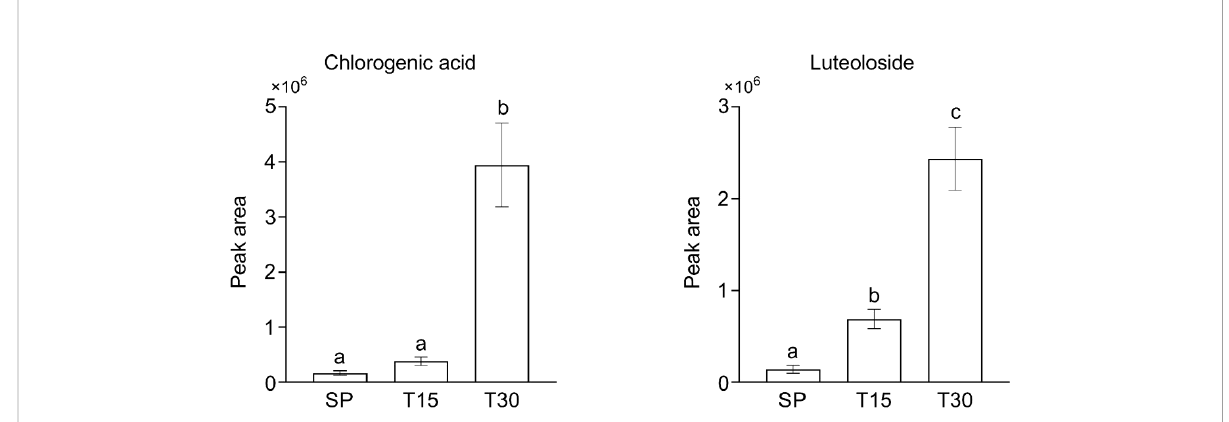
FIGURE 8 The content of chlorogenic acid and luteoloside in samples. Leaves of L. japonica were collected at SP, T15, and T30. CGA and luteoloside were extracted by methanol and analyzed by HPLC. Data are shown as mean ± S.D. from three independent biological replicates. Different lowercase letters indicate statistically signi fi cant differences as measured by Tukey ’ s test (p<